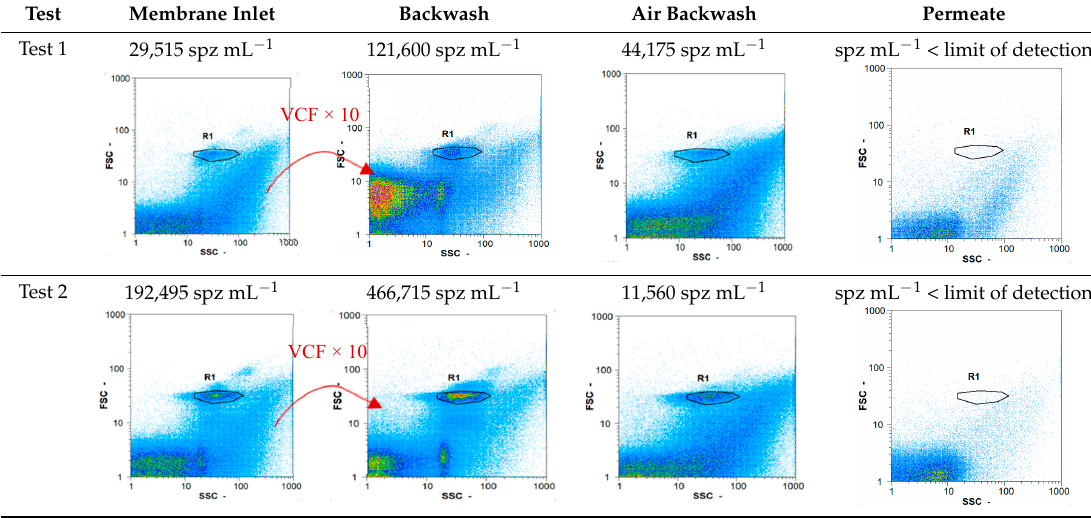
Table 8. Flow cytometry of spermatozoa—(J = 60 L h − 1 m − 2 and t filtration = 60 min; accidental pollution) for 2 feed concentrations.